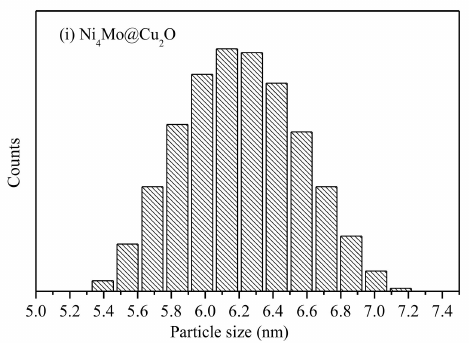
Figure 2. ( a ) TEM images of Ni 9 Mo 1 catalyst, ( b ) a HRTEM image of Ni 9 Mo 1 catalyst, ( c ) TEM images of Ni 9 Mo 1 (Pr 2 O 3 ) 0.375 catalyst, ( d ) a HRTEM image of Ni 9 Mo 1 (Pr 2 O 3 ) 0.375 catalyst, ( e ) TEM images of Ni 4 Mo@Cu 2 O catalyst, ( f ) a HRTEM image of Ni 4 Mo@Cu 2 O catalyst, ( g ) metal particles size distribution of Ni 9 Mo 1 , ( h ) metal particles size distribution of Ni 9 Mo 1 (Pr 2 O 3 ) 0.375 , and ( i ) metal particles size distribution of Ni 4 Mo@ Cu 2